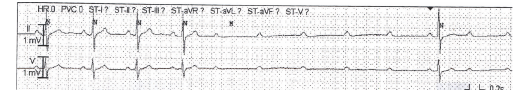
Figure 1: Cardiac telemetry recorded during patient’s “aura” type symptoms demonstrating transient high degree AV block with pauses of up to six seconds.